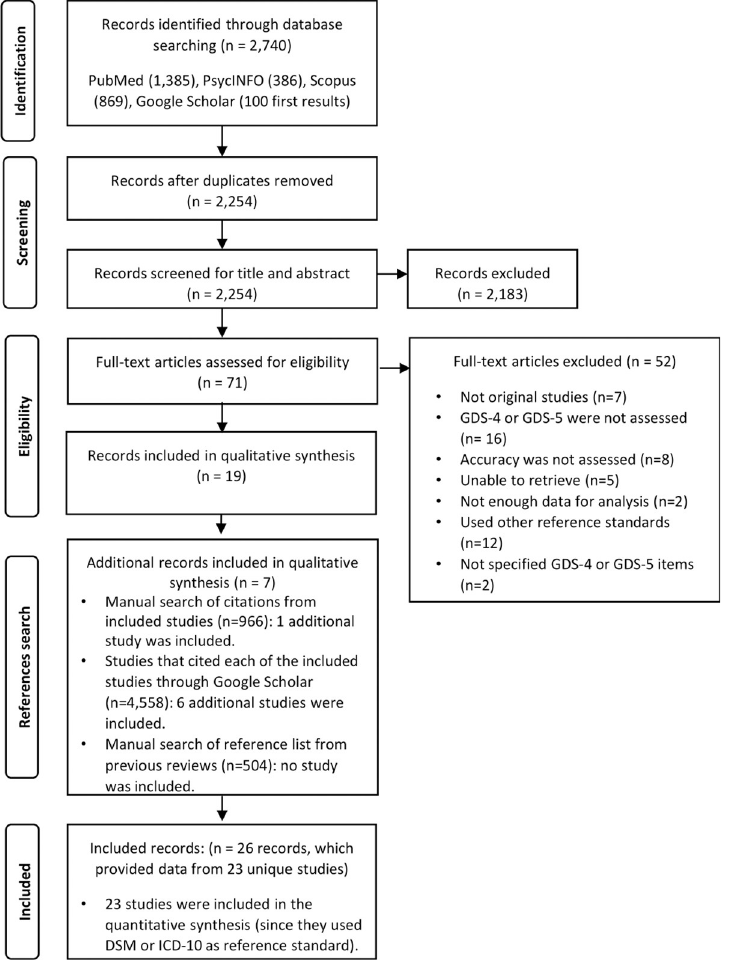
Fig 1. Flow diagram (study